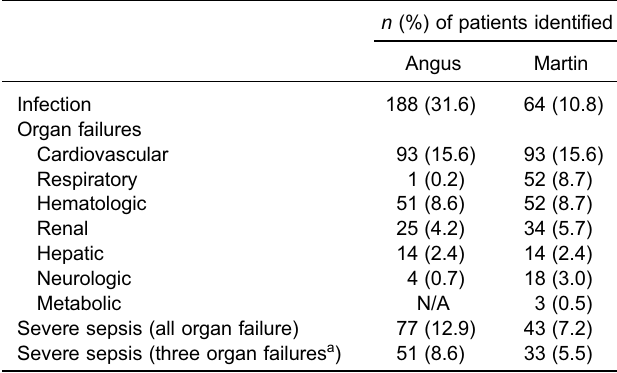
Table 2. Identi fi cation using recorded diagnoses ( n =